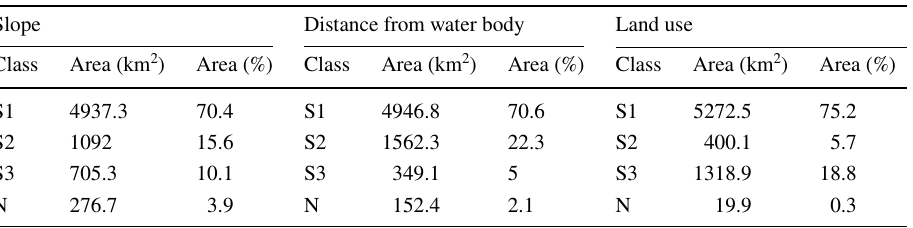
Table 11 Areal distribution of